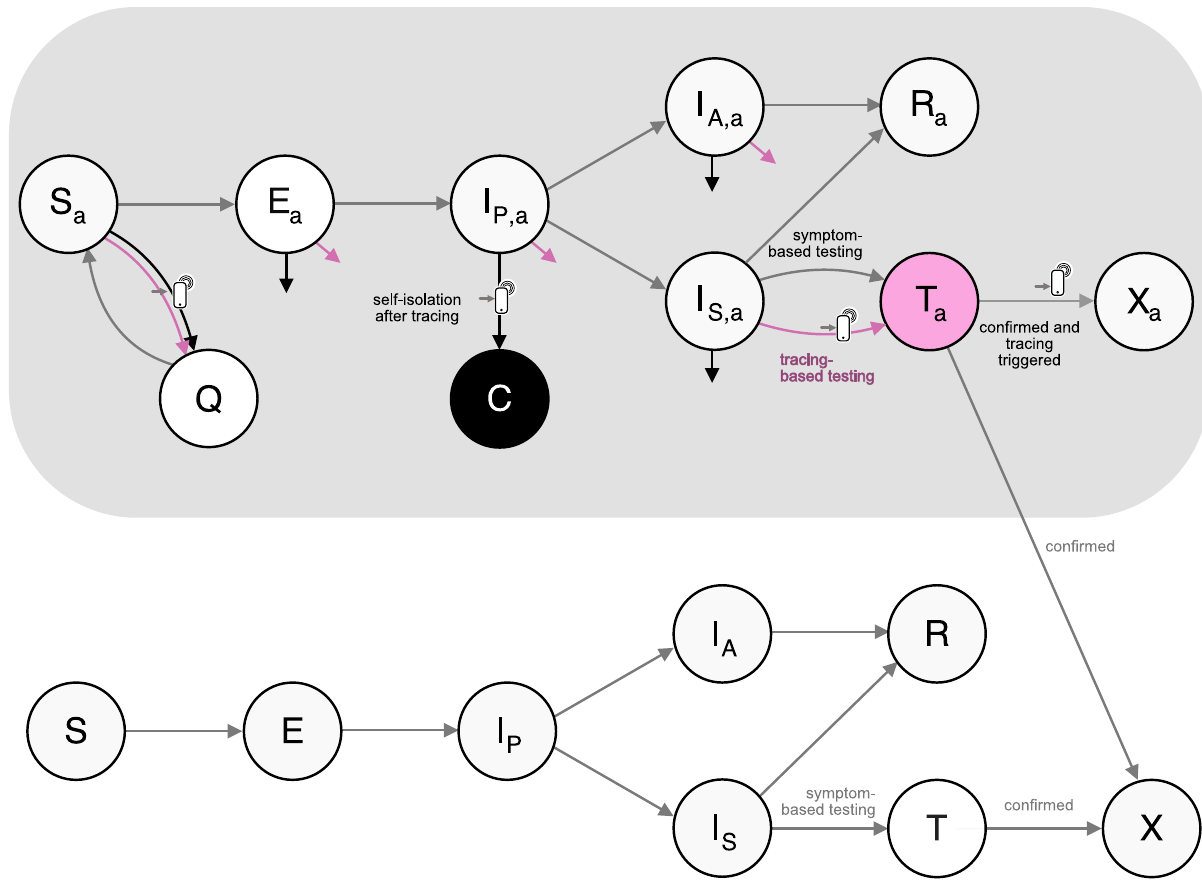
Fig 1. Schematic representation of the epidemic digital contact tracing model. App-participating individuals and groups are denoted by subscript a . Following an infection, susceptibles S ( a ) become exposed E ( a ) and enter a presymptomatic infectious state I P (, a ) . Susceptible individuals can be infected by any neighbor in any infectious state ( I , I , I ). After the presymptomatic phase, individuals become either asymptomatic I A (, a ) P (, a ) S (, a ) symptomatic infectious I S (, a ) and can either recover R ( a ) or, if symptomatic, they can be identified by symptom-based testing, i.e. enter T ( a ) , and are not infectious anymore. Tested non-app-participants ( T ) enter the final infected and quarantined state X . Tested app participants ( T positive test result and enter X , or not and enter X . The state transitions occur at rates listed in Table 1. When individuals upload the test result ( T a X a ) a series of conditional events is triggered. Infected app-participating neighbors ( E a , I P , a , I A , a , I S , a ) either self-quarantine C (black arrows) or get (pink arrows), potentially inducing further tracing events. Susceptible neighbors always self-quarantine ( Q ) and return to the susceptible tested T a population afterwards.